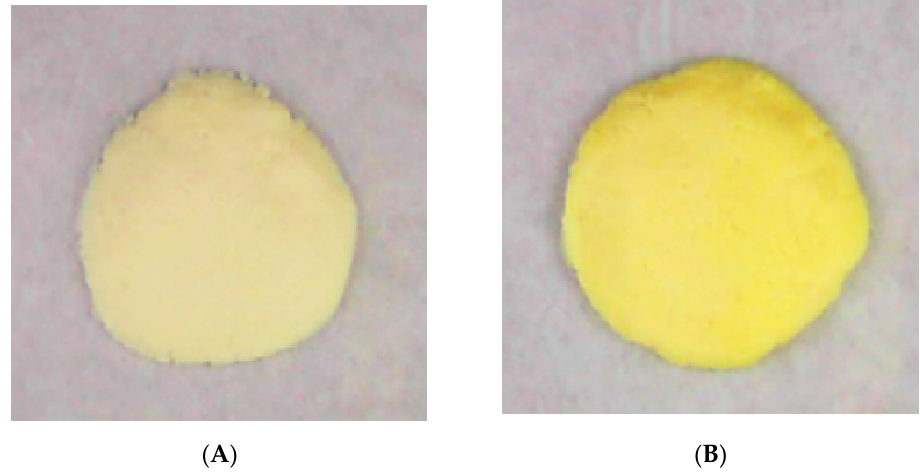
Figure 2. The appearance of ricotta cheese samples with no liposomes ( A ) and 2% liposomal capsu- lated saffron extract ( B ).